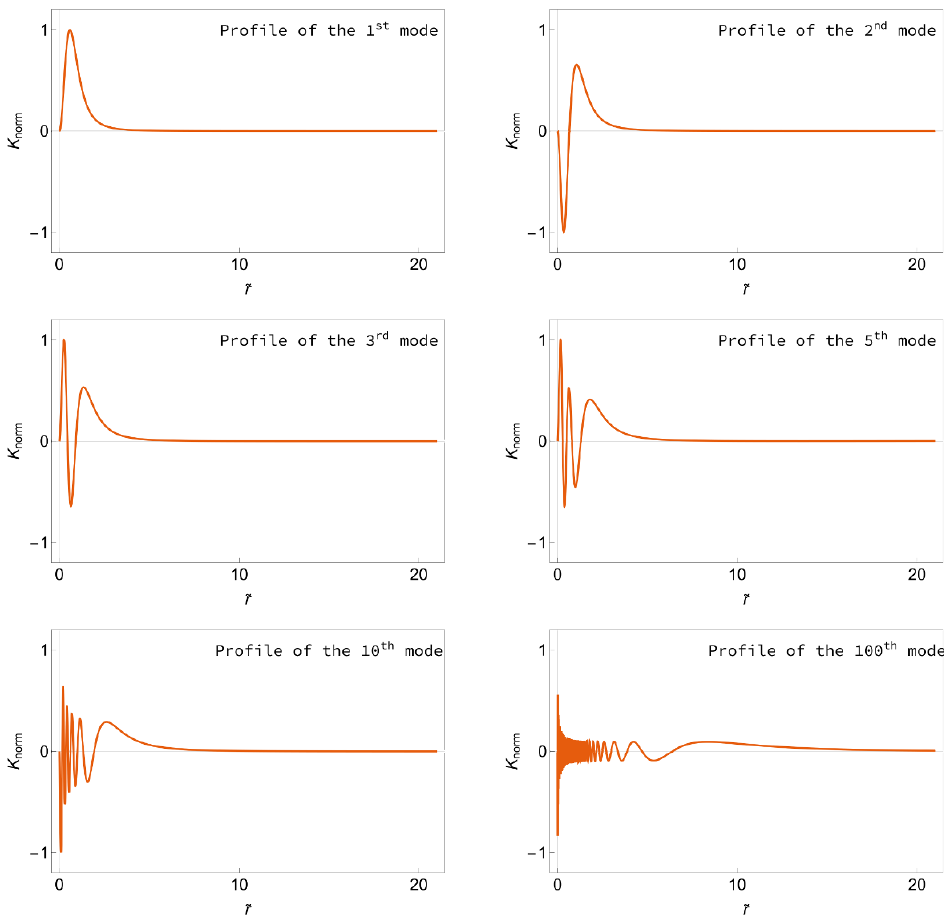
Figure 4 . Numerically obtained radial wavefunctions of several di(cid:11)erent excitation modes of an asymptotically AdS 2 (1,0,1) superstratum solution with b = 1, p = q 1 = q 2 = 1 and l = 2, plotted as functions of ~ r .